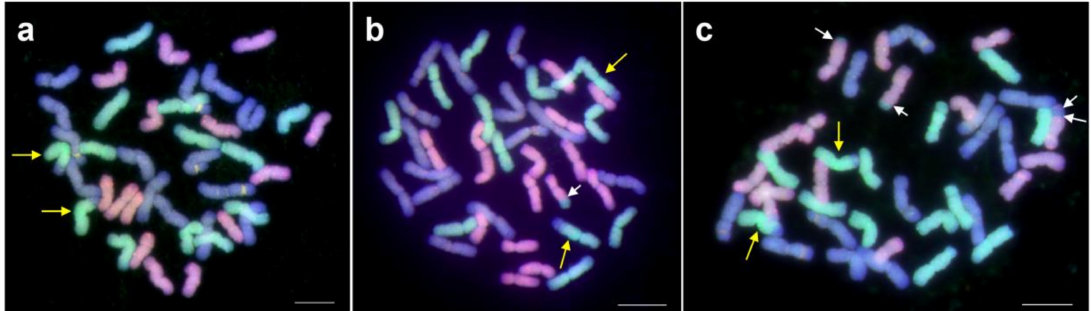
Figure 2. GISH patterns of mitotic metaphase chromosomes in the absence of 5M g #1 and Ph1 ( ph1bph1b ). ( a ) No recombinant chromosomes; ( b ) one recombinant chromosome; ( c ) three recombinant chromosomes. White arrows indicate the recombinant chromosomes; A-, D-, and B-genome chromosomes were visualized by green, red, and blue fluorescence, respectively. Recombinants with multiple COs and COs in the proximal region were not detected in 10 ph1b mutant plants analyzed. Yellow arrows point to the rearranged chromosome 4A. Bars = 10 µ